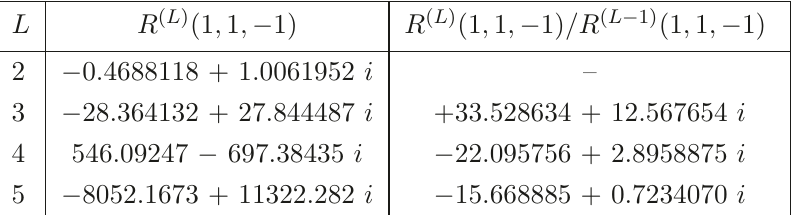
Table 7. The value of the remainder function at ( u, v, w ) = (1 , 1 , − 1) at loop order L , as well as the ratio to the previous loop order. The five loop to four loop ratio is already not far from the asymptotic ratio of − 16 for the cusp anomalous